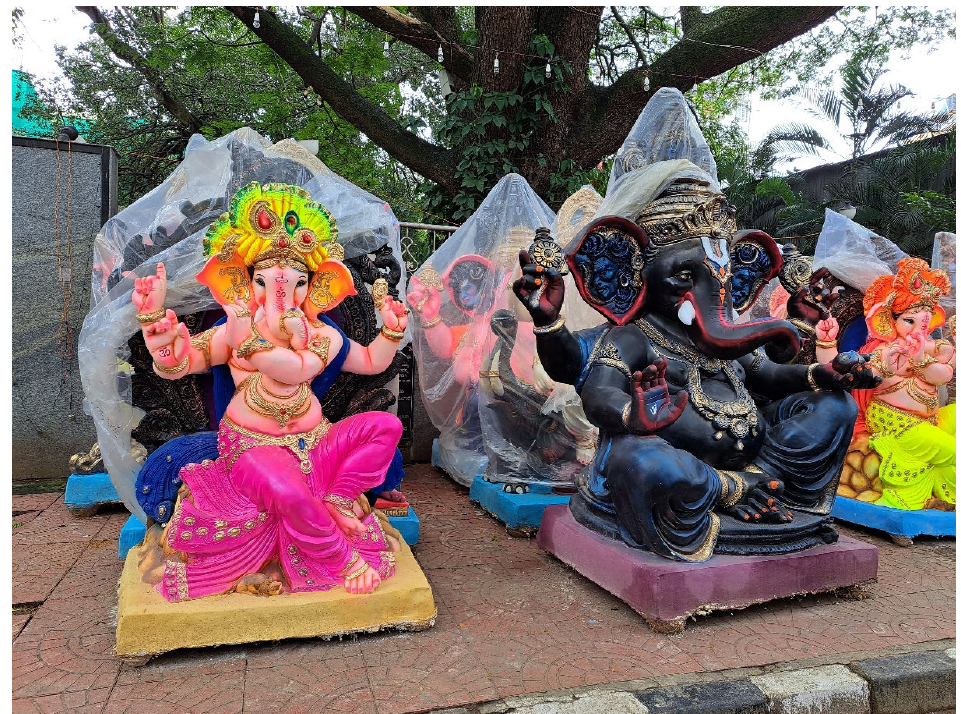
Figure 2. Large Ganeshas for sale in the week prior to Ganesha Chaturthi. Picture taken by author, 25 August 2022,